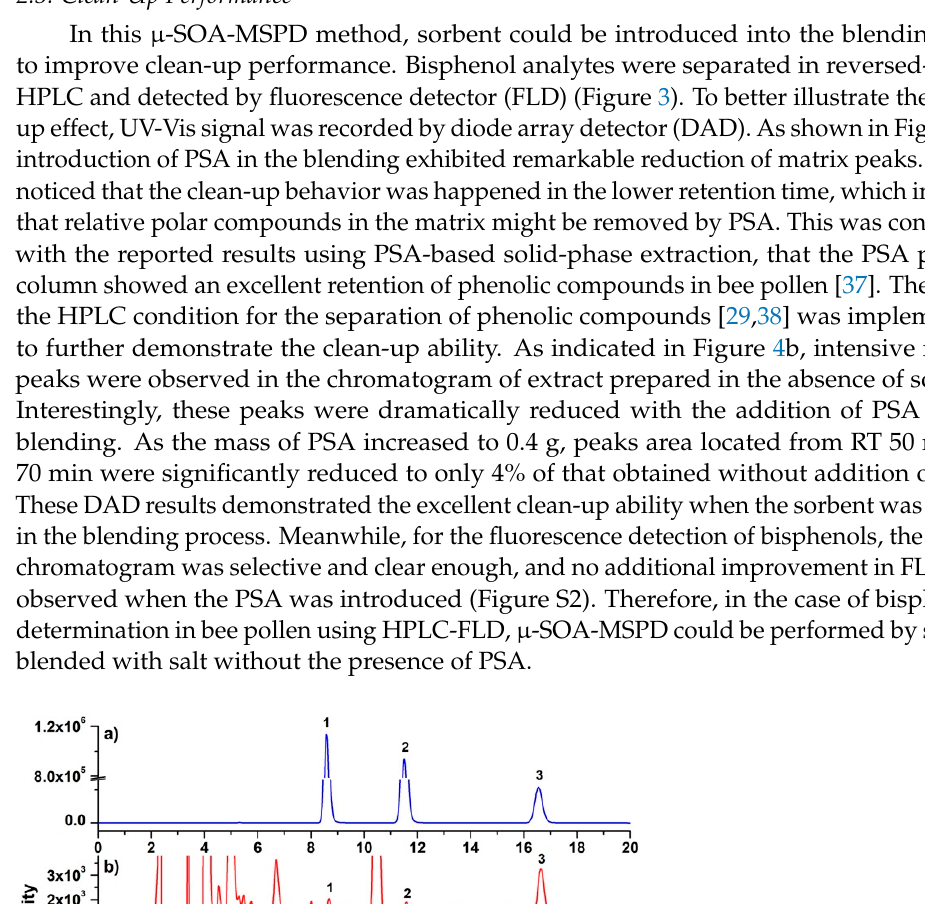
Figure 4. Representative HPLC-DAD chromatograms of extract under different masses of PSA. ( a ) Separation was performed for the analysis of bisphenols ( λ = 210 nm), ( b ) separation was per- formed for the analysis of phenolic compounds ( λ = 280 nm).